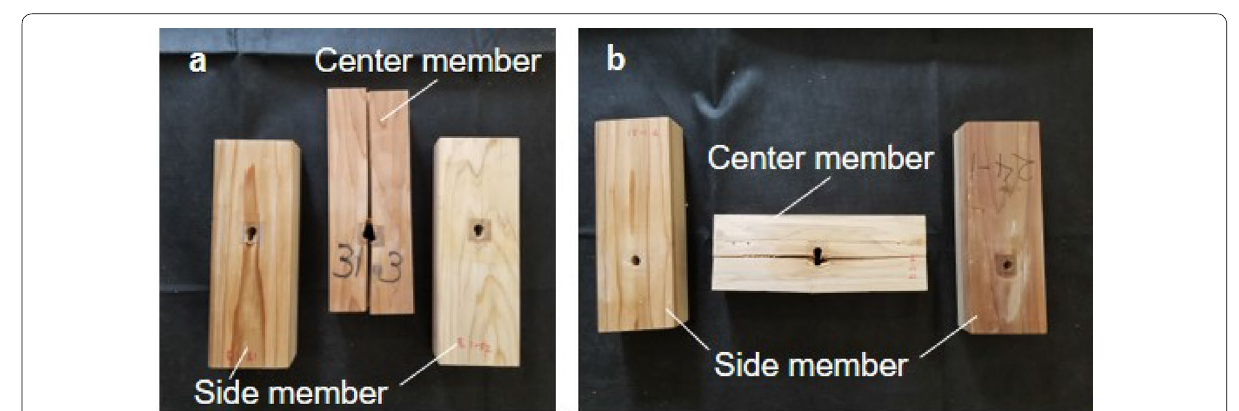
Fig. 9 Splitting failure of center member. a Groups loaded parallel to the grain. b Groups loaded perpendicular to the